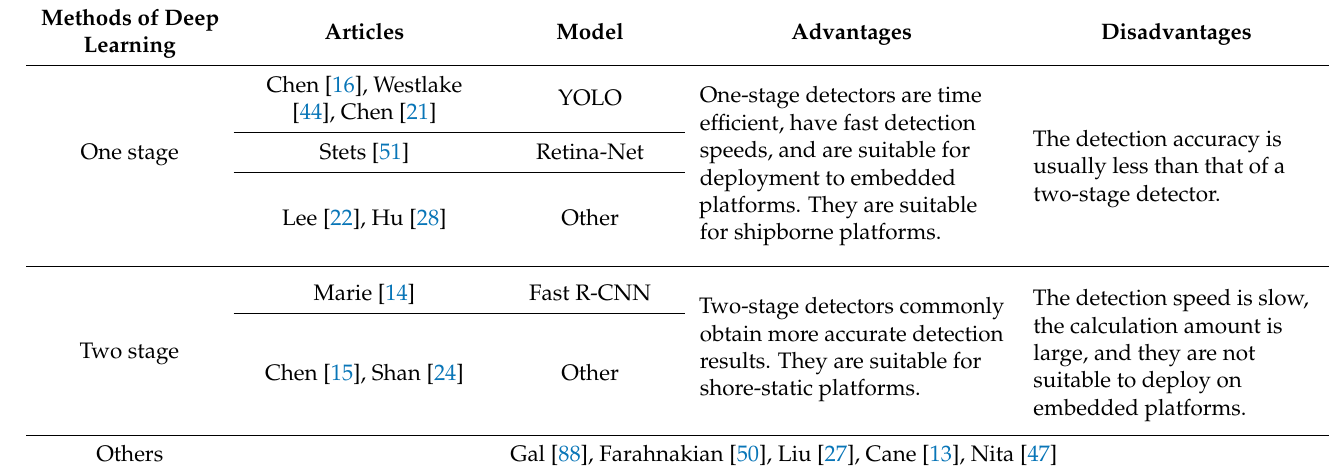
Table 7. Application of deep learning models in ship